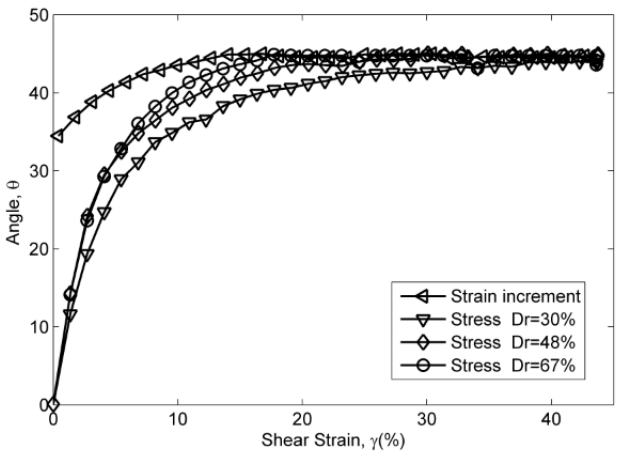
Figure 13. Rotation of principal axes of stresses and strain increment at different relative densities [60].